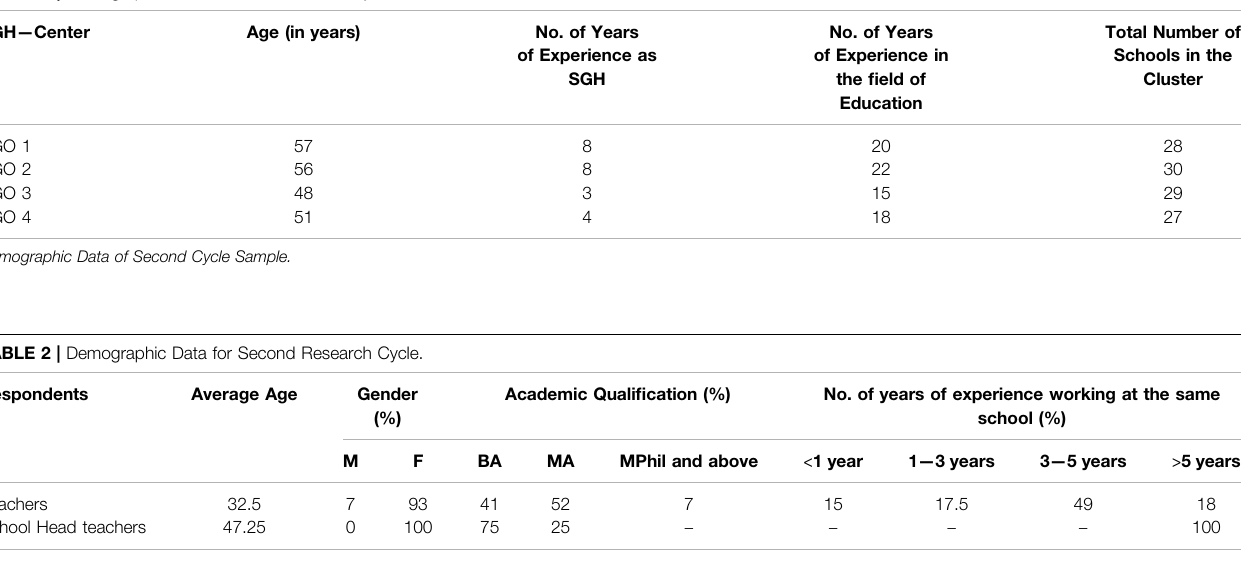
TABLE 1 | Demographic Data for First Research Cycle.